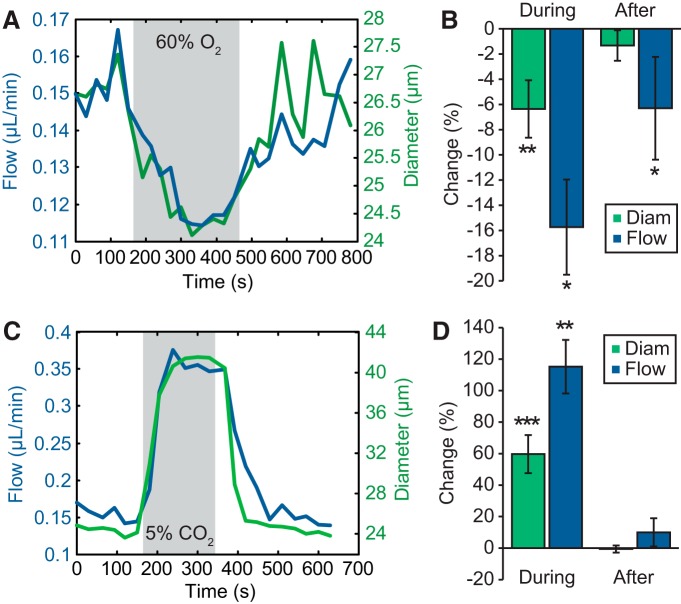
Blood flow changes in primary arterioles in response to hyperoxic and hypercapnic challenge. A, C, Representative traces of flow (blue) and diameter (green) in response to hyperoxia (A) and hypercapnia (C). The period of hyperoxic or hypercapnic challenge is indicated by gray shading. B, D, Percentage change in diameter and flow during and after the challenge period. *p < 0.05, **p < 0.01, ***p < 0.001. n = 4 for hyperoxic challenge and n = 3 for hypercapnic challenge. Diam, Diameter.